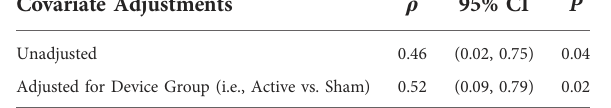
TABLE 3 Spearman correlations between Δ NRS pain and Δ CV(T i ). Covariate Adjustments